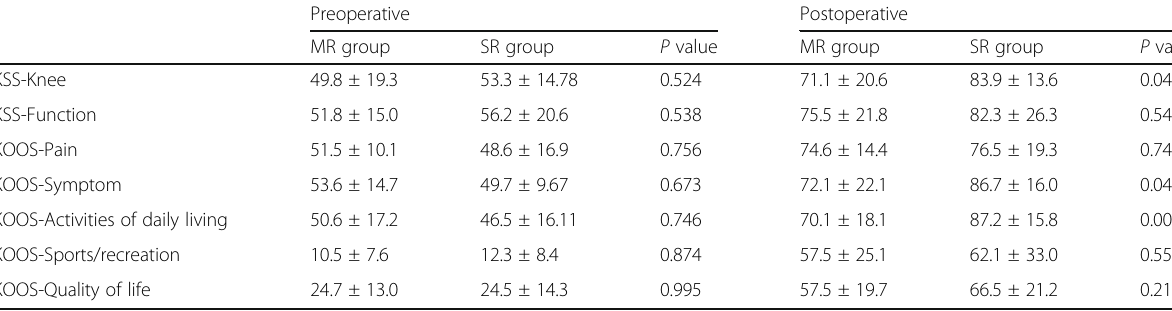
Table 2 KSS and KOOS Scores (mean ± SD) before and after TKA Preoperative Postoperative